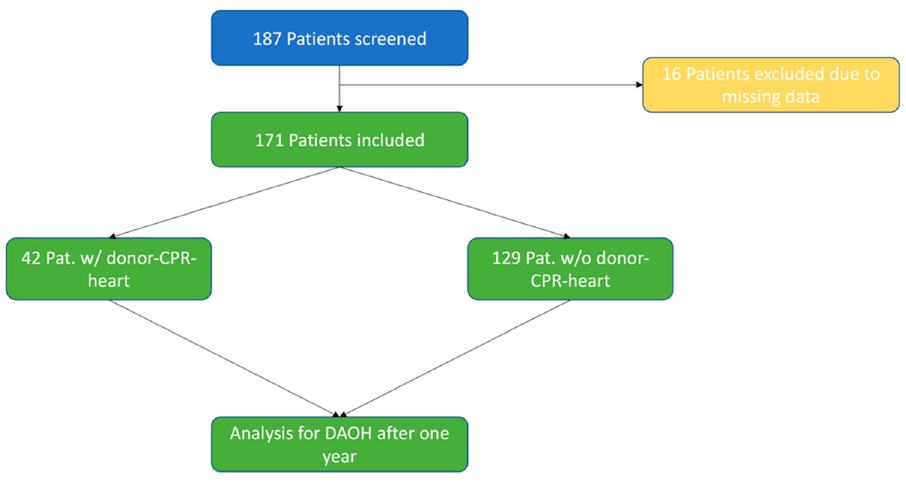
Figure 1. Study flow chart.